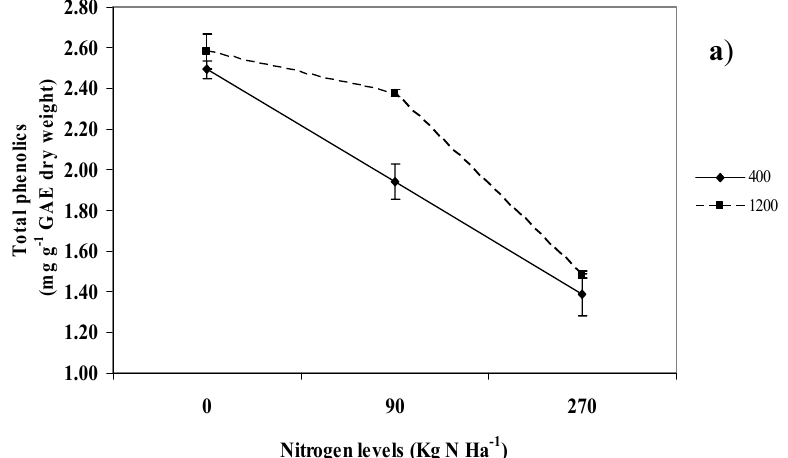
Figure 3. Interaction effects between CO and nitrogen levels on total phenolics ( a ) and 2 total flavonoids ( b ) content of L. pumila . N = 12. Bars represent standard error of differences between means